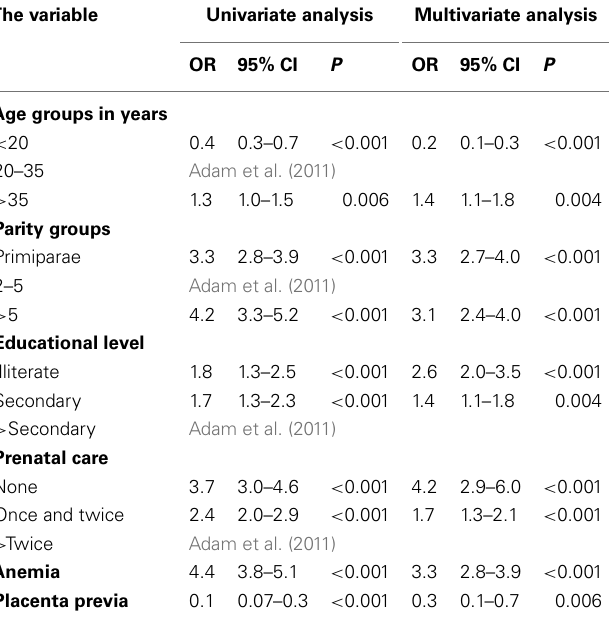
Table 2 | Risk factors for pre-eclampsia in Medani Hospital using univariate and multivariate